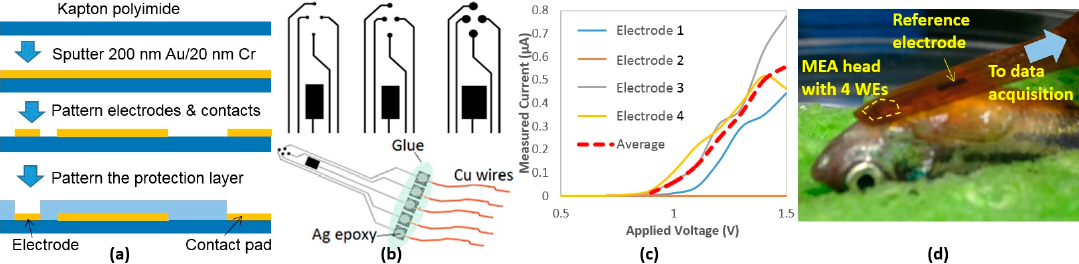
Figure 1. ( a ) Fabrication processes of the MEA membranes; ( b ) Different electrode sizes and the complete device; ( c ) Impedance characterization curves of one 300- µ m MEA membrane; ( d ) The